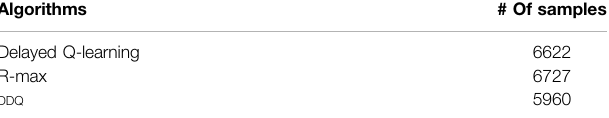
TABLE 1 | Average # of samples for reaching 4 ε optimality. Algorithms